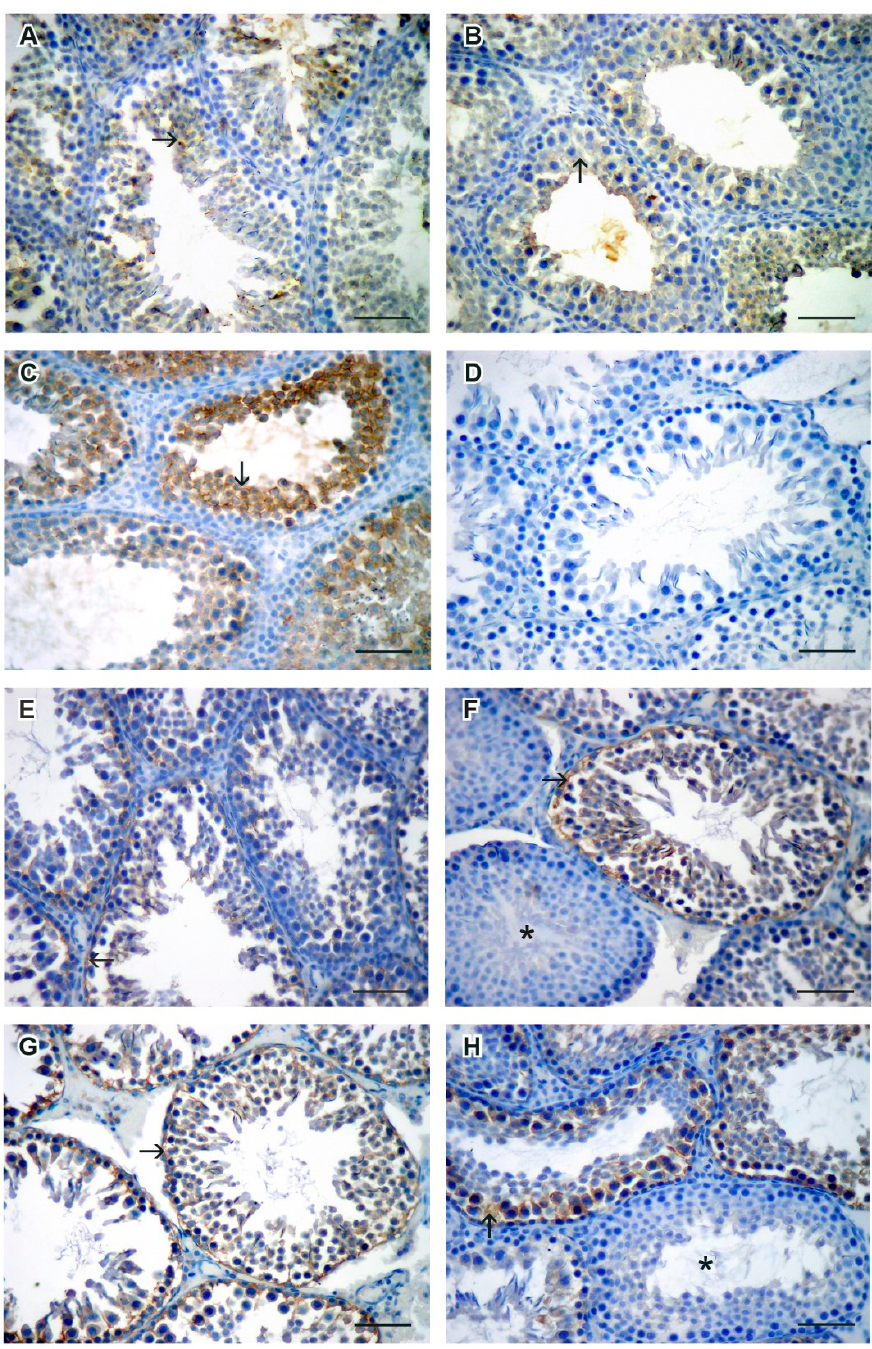
Figure 2. Representative images of HNE ( A – D ) and 8-OHdG ( E – H ) expression ( → ) in the rat testes of groups 1 ( A , E ), 2 ( B , F ), 3 ( C , G ), and 4 ( D , H ). Note the difference in the expression on neighboring tubules in images F and H (*- nonaffected tubule). DAB, hematoxylin counterstain, scale bar 50 µm. 4-hydroxy-2-nonenal (HNE), the marker of lipid peroxidation, showed the